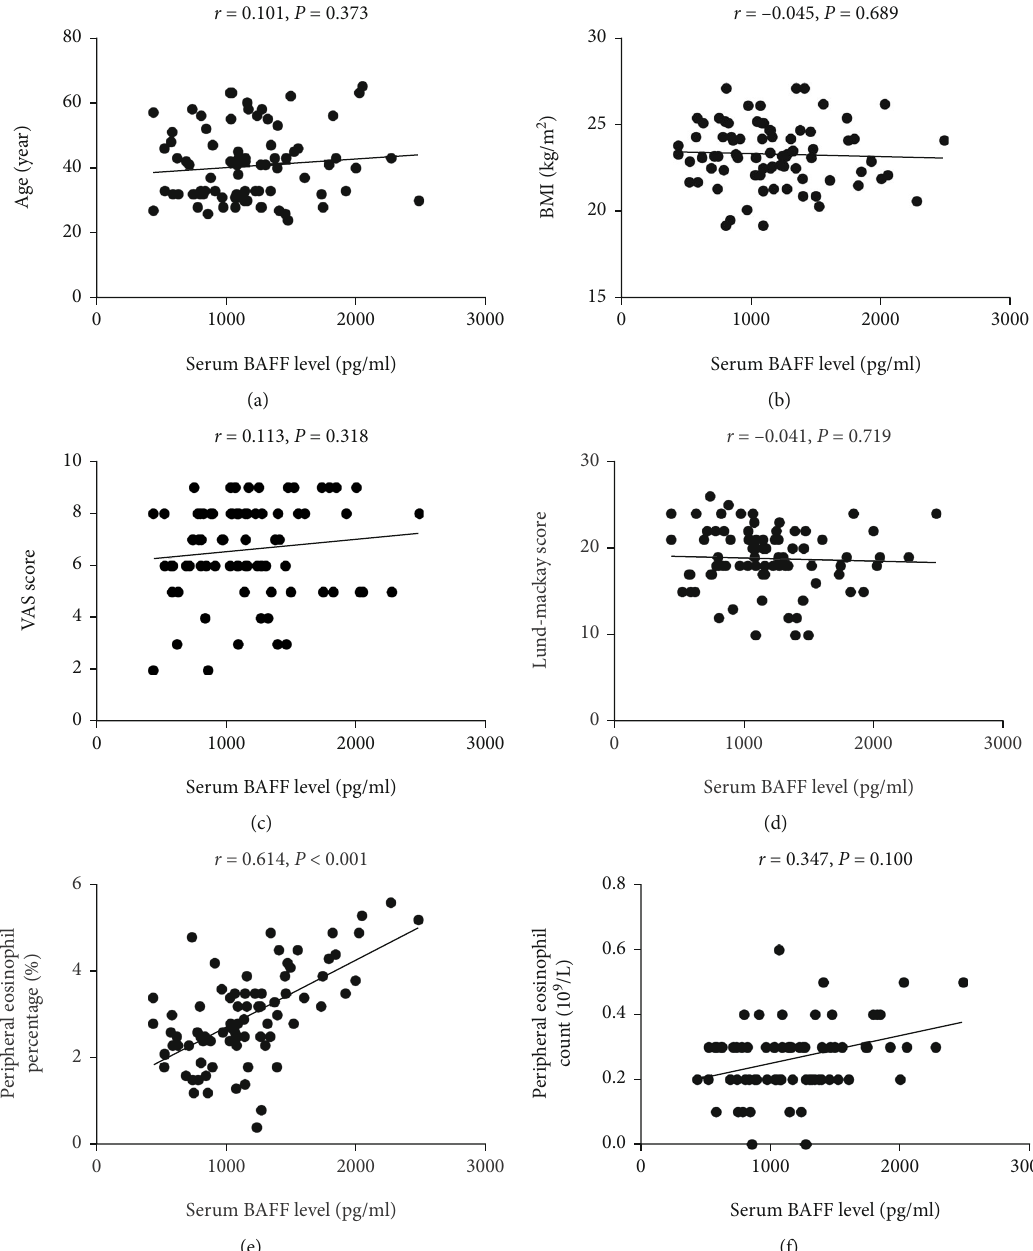
Figure 3: The associations between serum BAFF levels and clinical variables in CRSwNP patients. Elevated serum BAFF levels exhibited positive correlation with peripheral (e) eosinophil count, but did not link with (a) age, (b) BMI, (c) VAS score, (d) Lund-Mackay score, and (f) peripheral eosinophil percentage. BAFF: B cell-activating factor; CRSwNP: chronic rhinosinusitis with nasal polyps; BMI: body mass index; VAS: visual analog